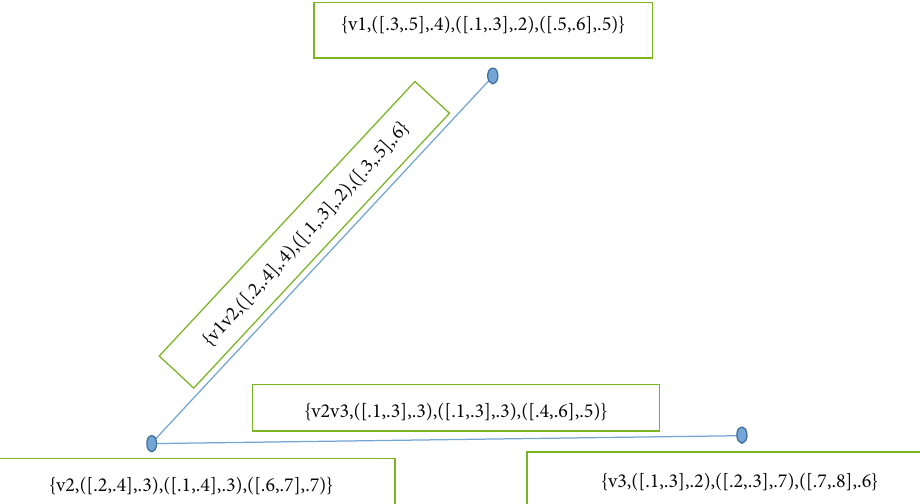
Figure 3: Shows a neutrosophic cubic graph, which is not regular as well as totally